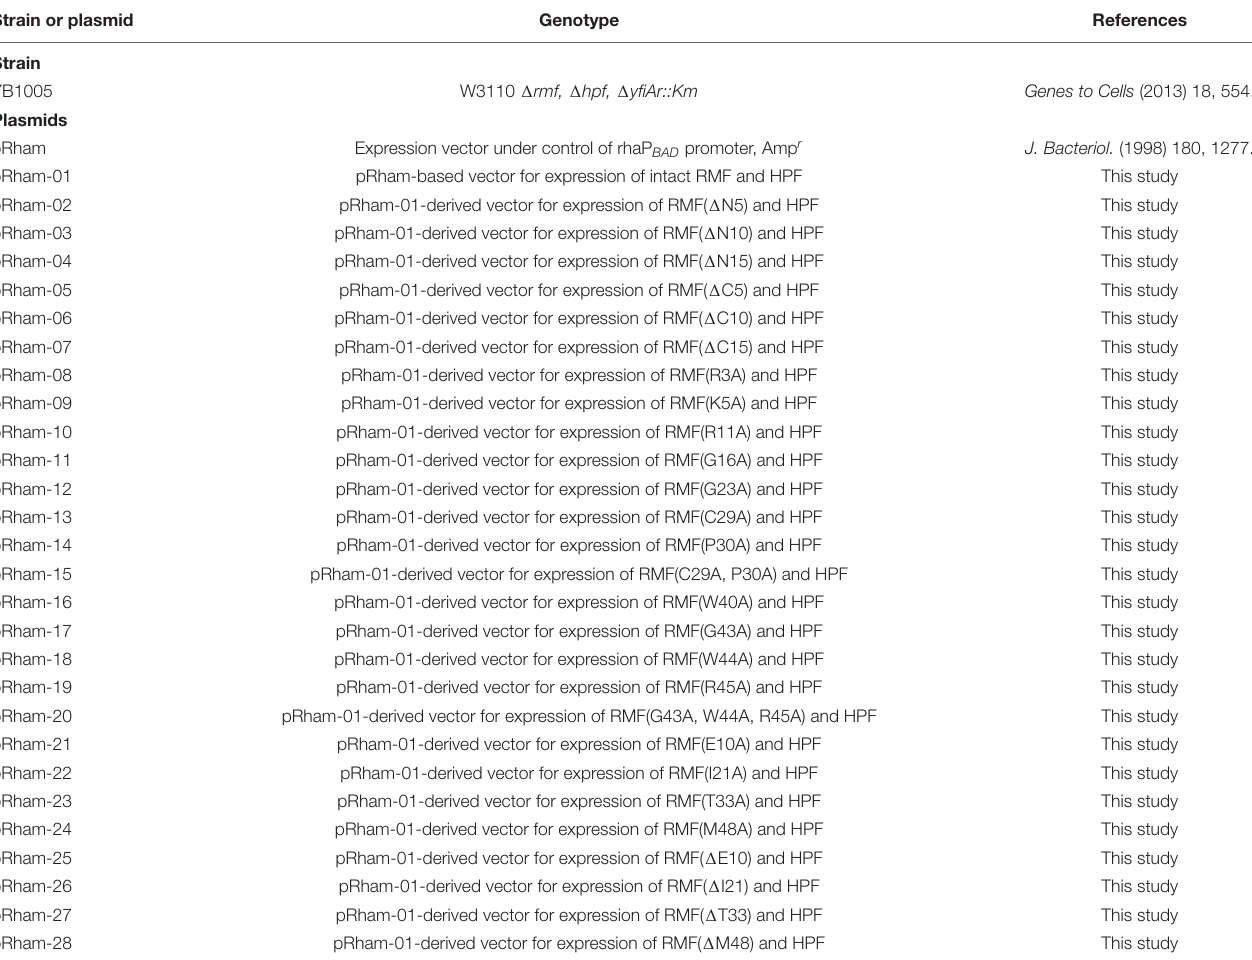
TABLE 1 | E. coli strain and plasmids used in this work. Strain or plasmid